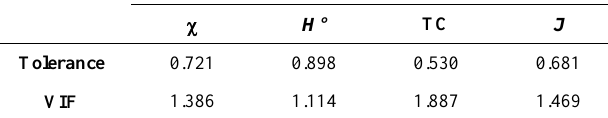
Table 3. Multicollinearity statistics.